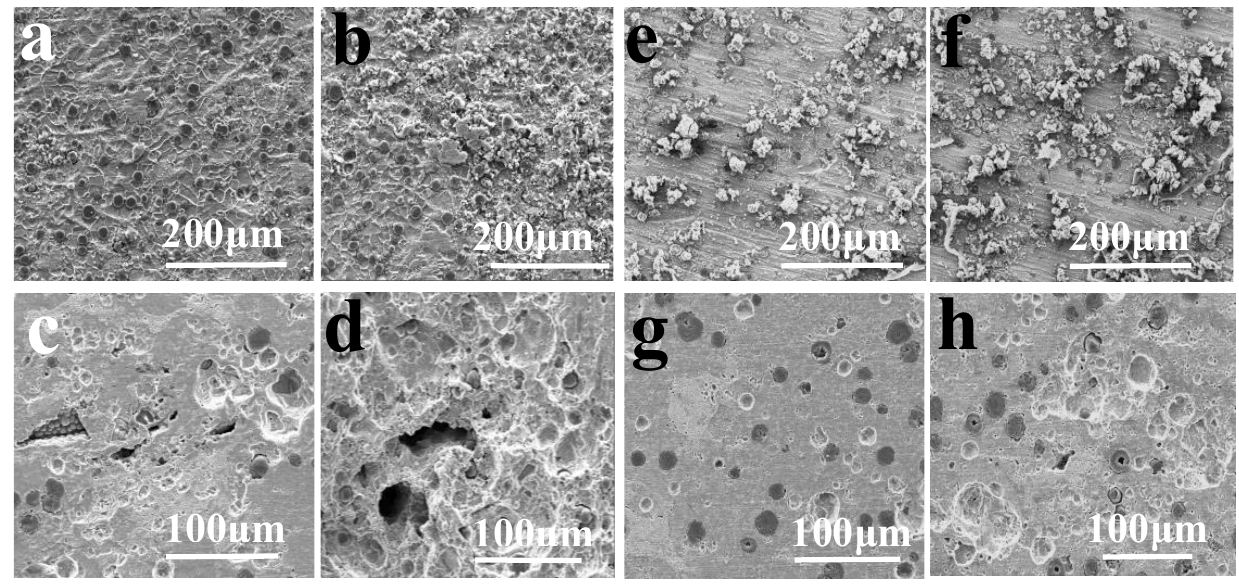
Figure 2. Surface corrosion morphology of different specimens after the immersion test. ( a , b , e , f ) Before and ( c , d , g , h ) after the corrosion rust removal. ( a , c , e , g ) Immersion at 120 h, and ( b , d , f , h ) immersion at 240 h. ( a~d ) Ductile iron with no surface mechanical treatment, ( e~h ) Ductile iron with surface mechanical treatment.